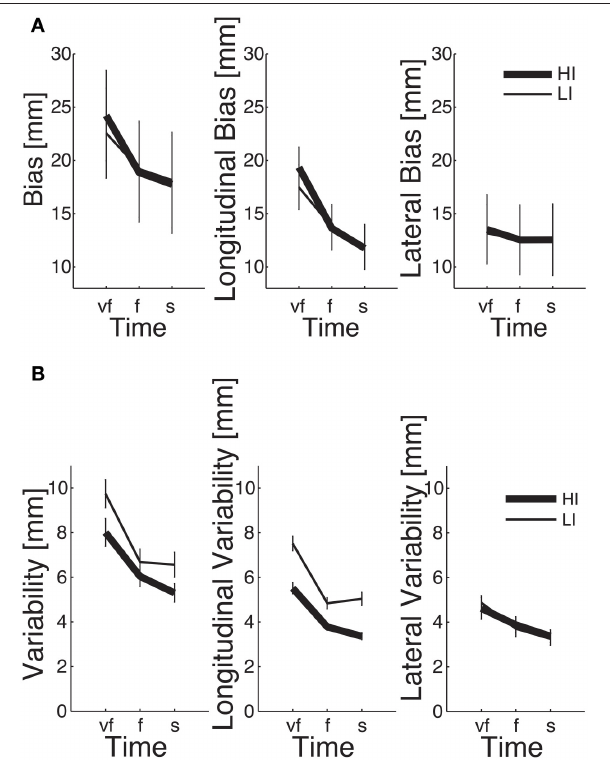
FIGURE 6 | Dependence of SAT curves on inertia, in total (left), longitudinal (middle), and lateral bias (right), for endpoint bias (A) and endpoint variability (B) . Thin and thick lines denote, respectively, low (LI) and high inertia (HI) directions. Vertical bars denote the